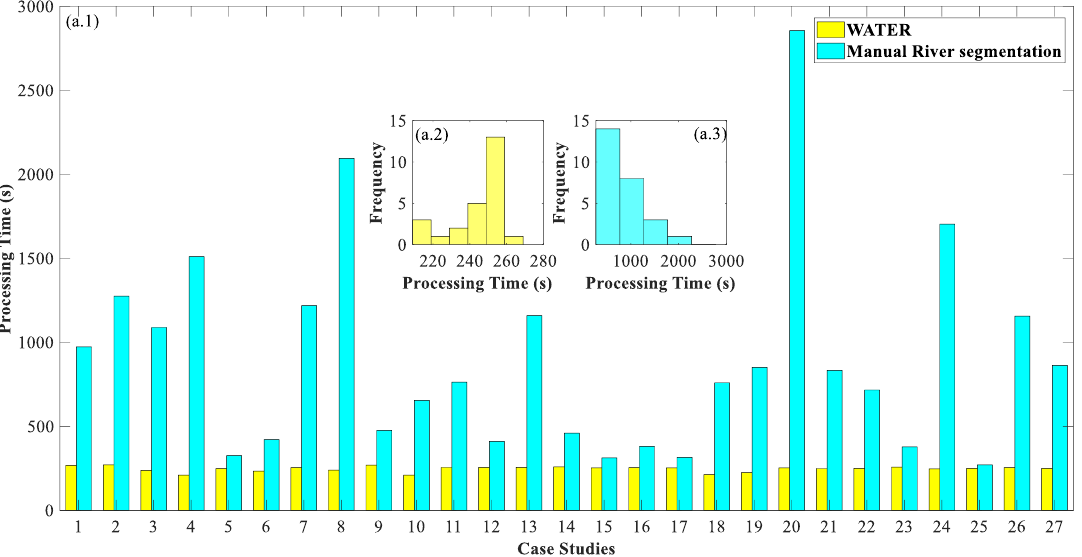
Figure 10. Confronting the processing time of all case studies analysed in terms of WATER (yellow) and manually-based (cyan) segmentation. ( a.1 ) Processing time for the 27 case studies. ( a.2 ) Histogram of the processing time by the automatic segmentation using WATER. ( a.3 ) Histogram of the processing time by manual segmentation. Worth mentioning is that the processing time is always lower for WATER than for manual segmentation.